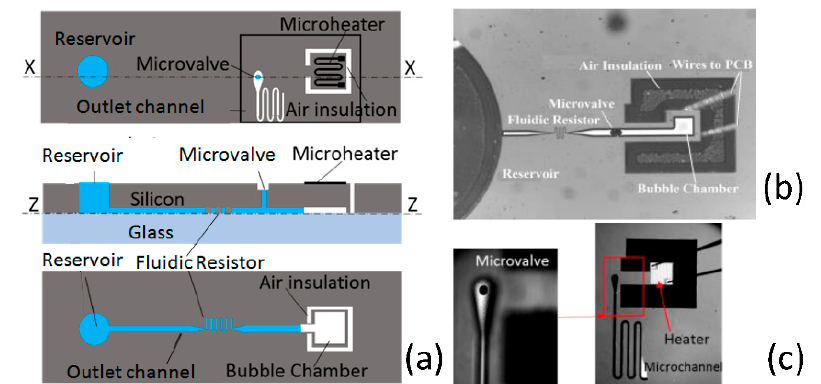
Figure 1. ( a ) Schematic of the thermally actuated capillary valve. Top: Top view, Middle: cross section. ( X-X), Bottom: cross section (Z-Z). ( b ) Micrograph of the device as seen through the glass side. ( c ). Micrograph of the device as seen from the silicon